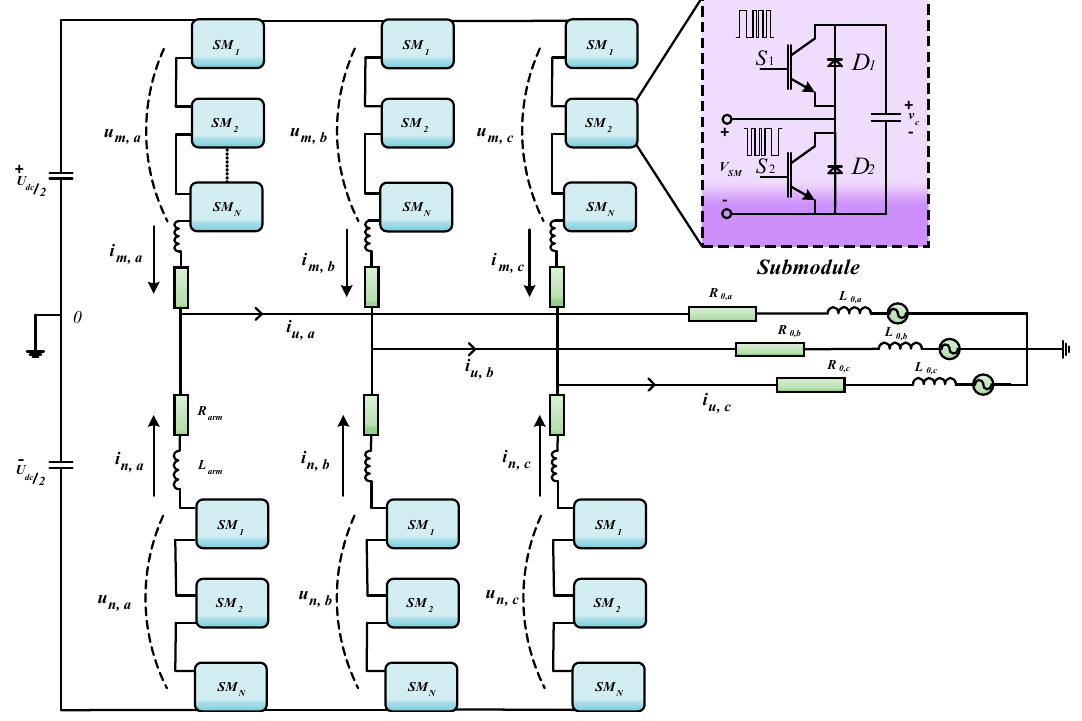
Figure 1. General MMC 3 phase structure.